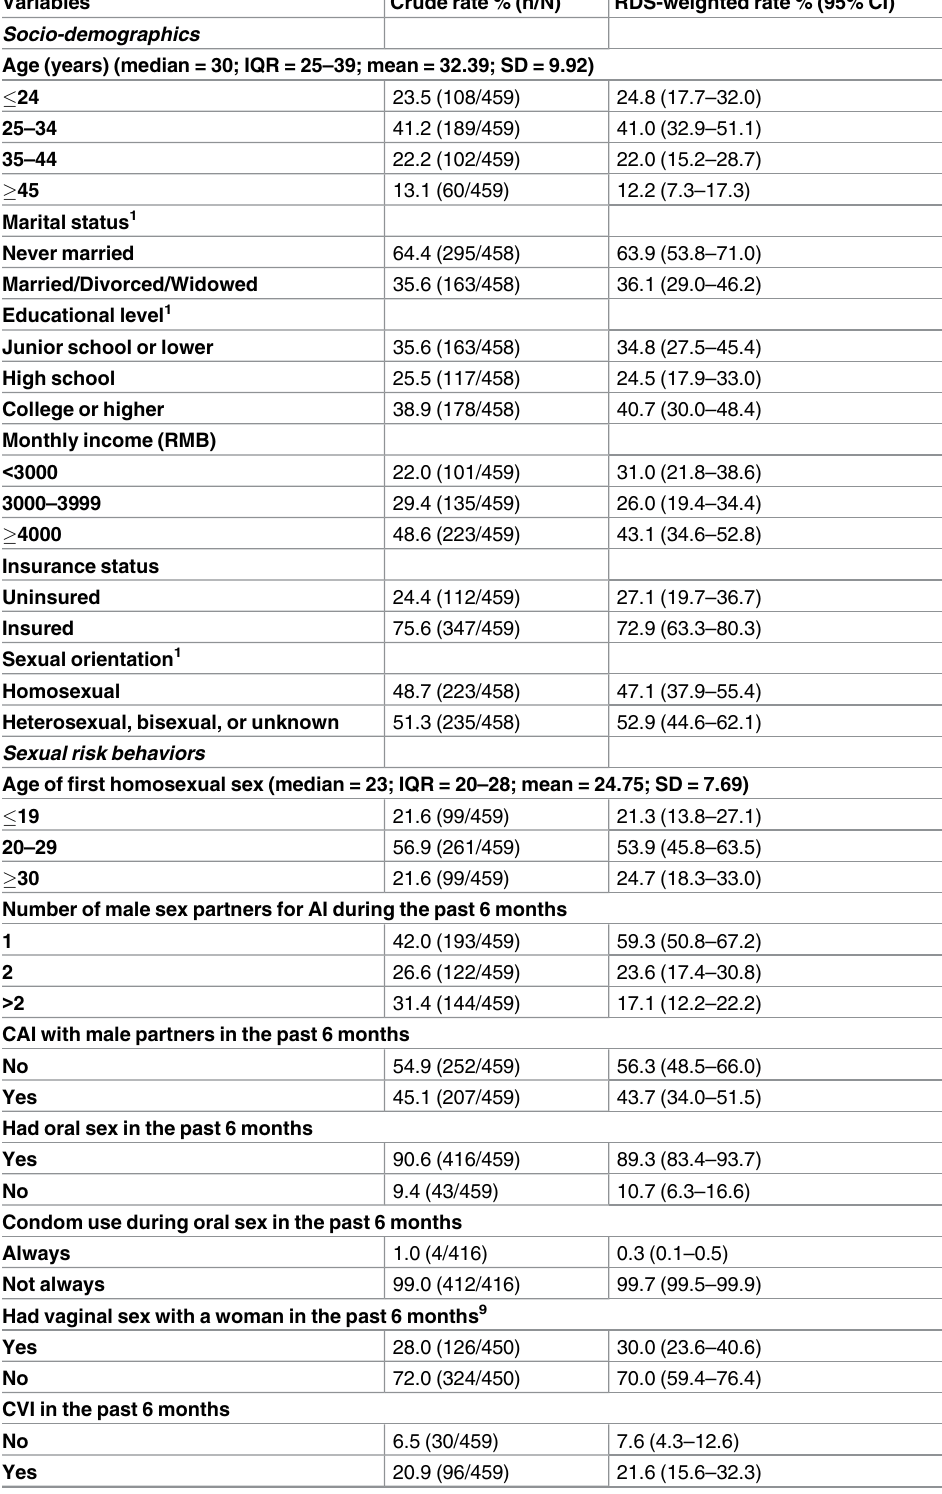
Table 1. Crude and weighted estimatesof characteristics of MSM in Hangzhou, China (N =